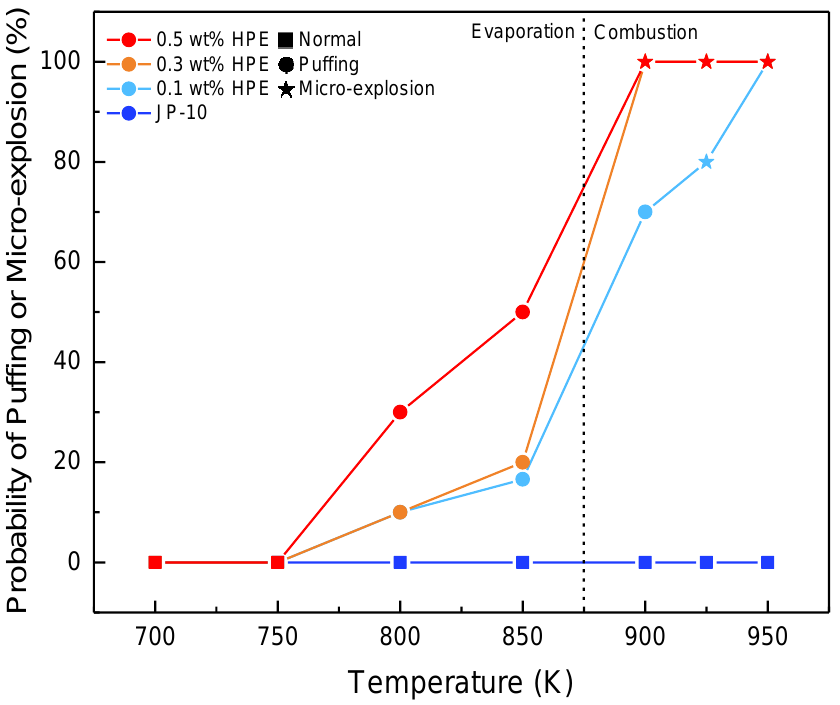
Figure 4. Variation in probabilities of puffing or micro-explosions with different HPE concentrations of JP-10 droplets at temperatures of 700–950 K. Each point represents the statistical probability of at least 20 experiments.